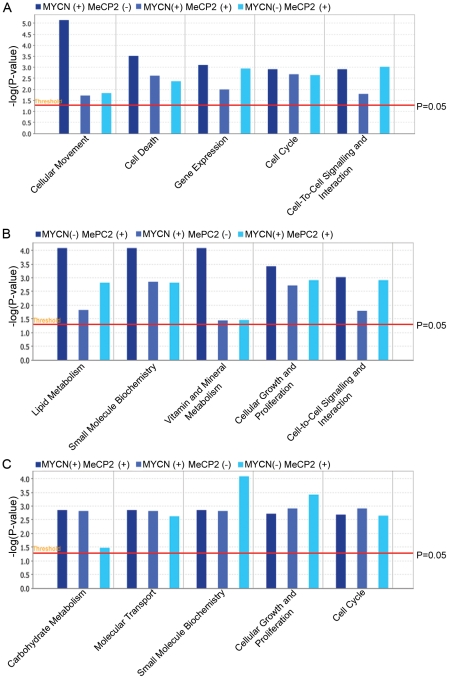
Pathway analysis of target genes.Comparison analysis of the top significant biological functions for (A) genes whose promoters are occupied by MYCN (B) genes whose promoters are occupied by MeCP2 (C) genes whose promoters are co-occupied by MYCN and MeCP2. Each panel represents the top five biological functions of each group of genes, and compares the significance of each of the functions across datasets. The significance scores for each biological function are represented as –log(P-value). The analysis was performed using the IPA software, significant biological functions were identified as having a p-value of less than P<0.05 (represented by a red bar).